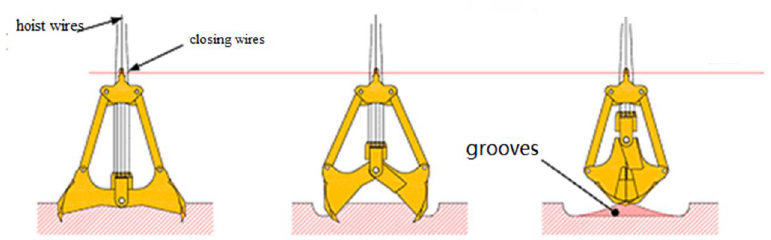
Figure 22. Normal digging grooves.